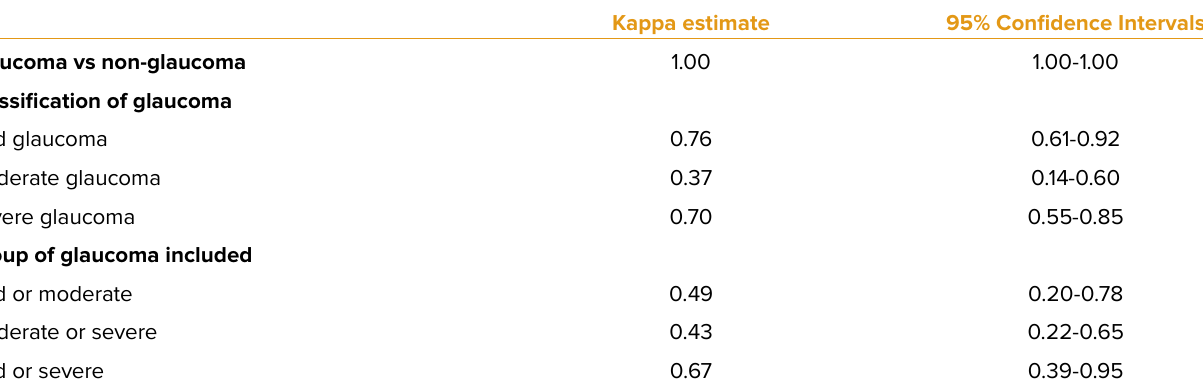
Table 2. Table showing the kappa agreement and 95% confidence intervals between Palm Scan VF2000 ® Virtual Reality